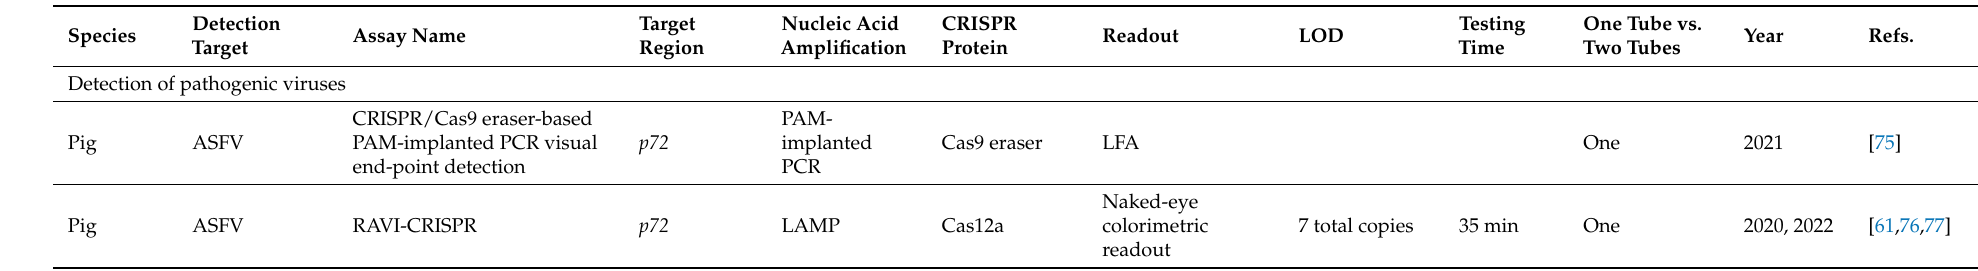
Table 2. Overview of applications of CRISPR-based nucleic acid detection in